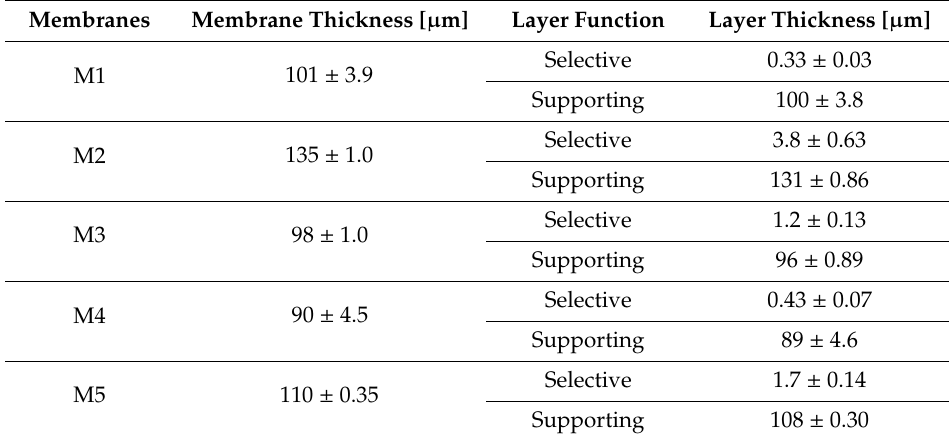
Table 2. The morphological characteristics of the prepared